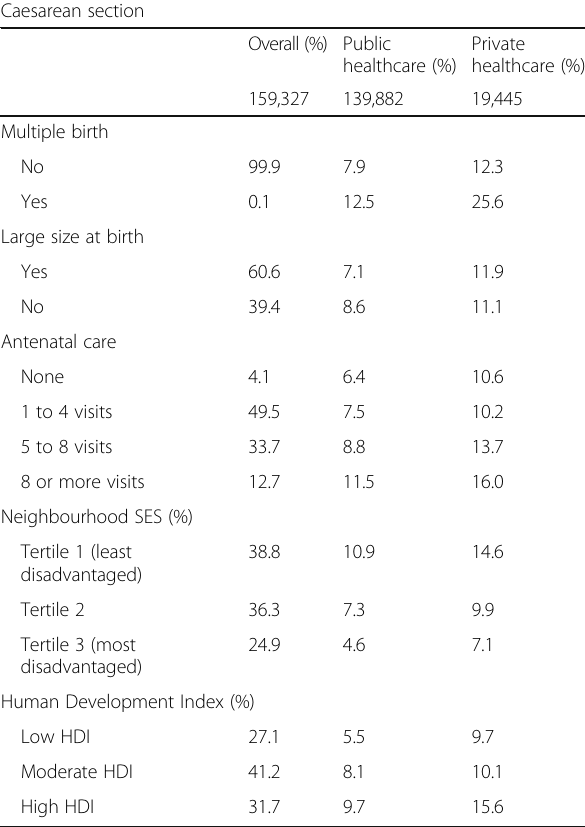
Table 2 Summary of pooled sample characteristics of the Demographic and Health Surveys data in sub-Saharan Africa Caesarean section